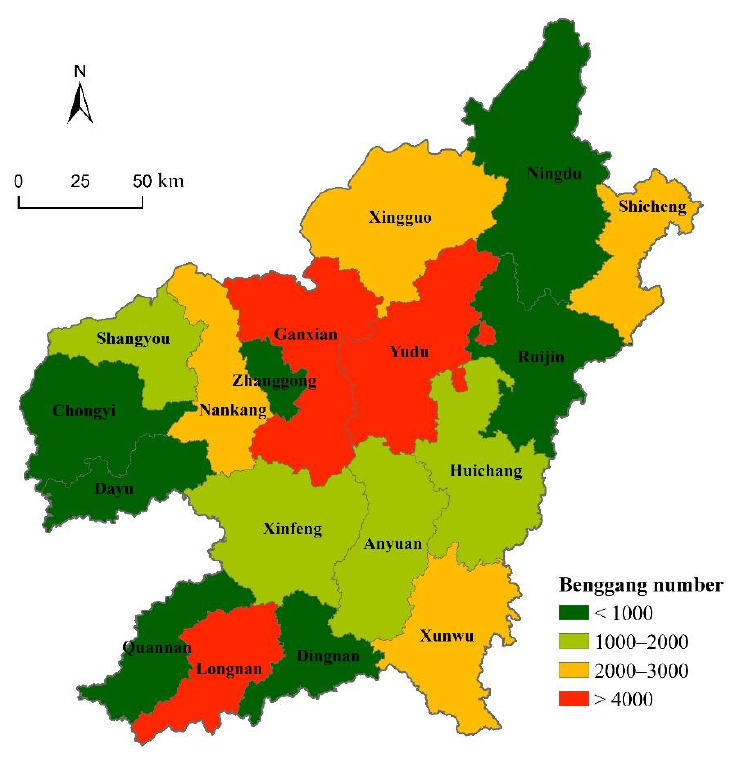
Figure 4. Distribution map of Benggang in Ganzhou City. Table 2. Statistics of Benggang in different counties (cities and districts) of Ganzhou